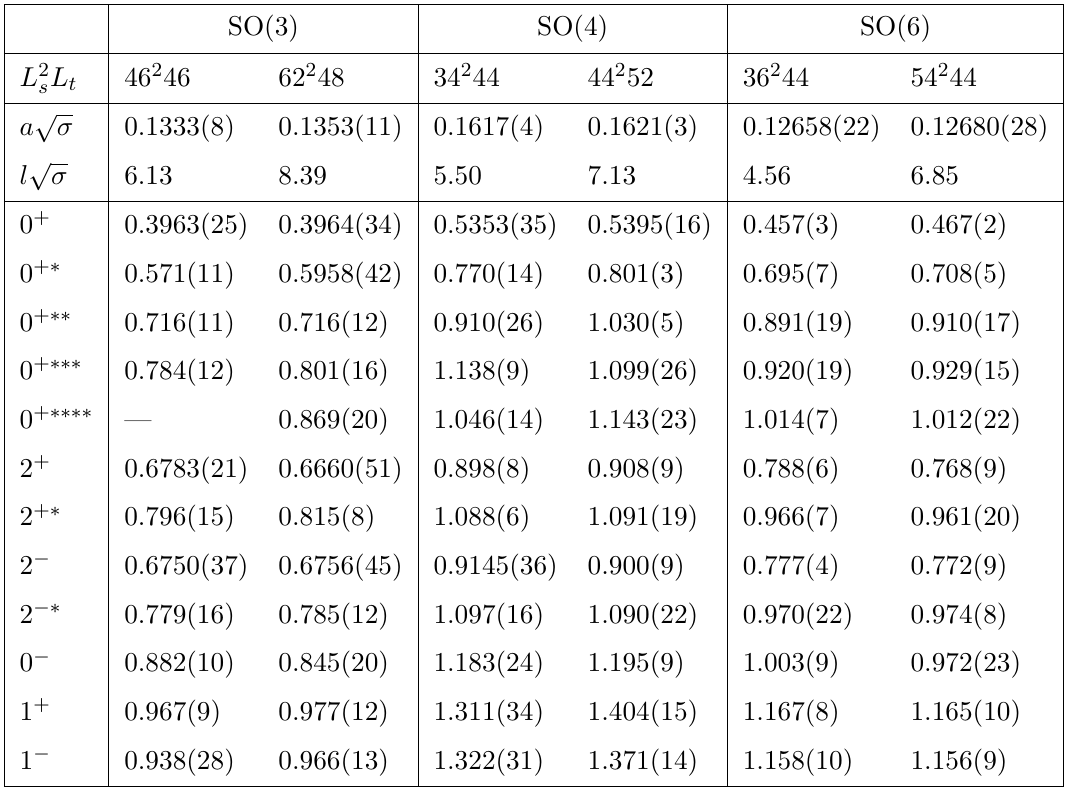
Table 4 . Finite volume test for glueball masses and the string tension in SO(3), SO(4) and SO(6)